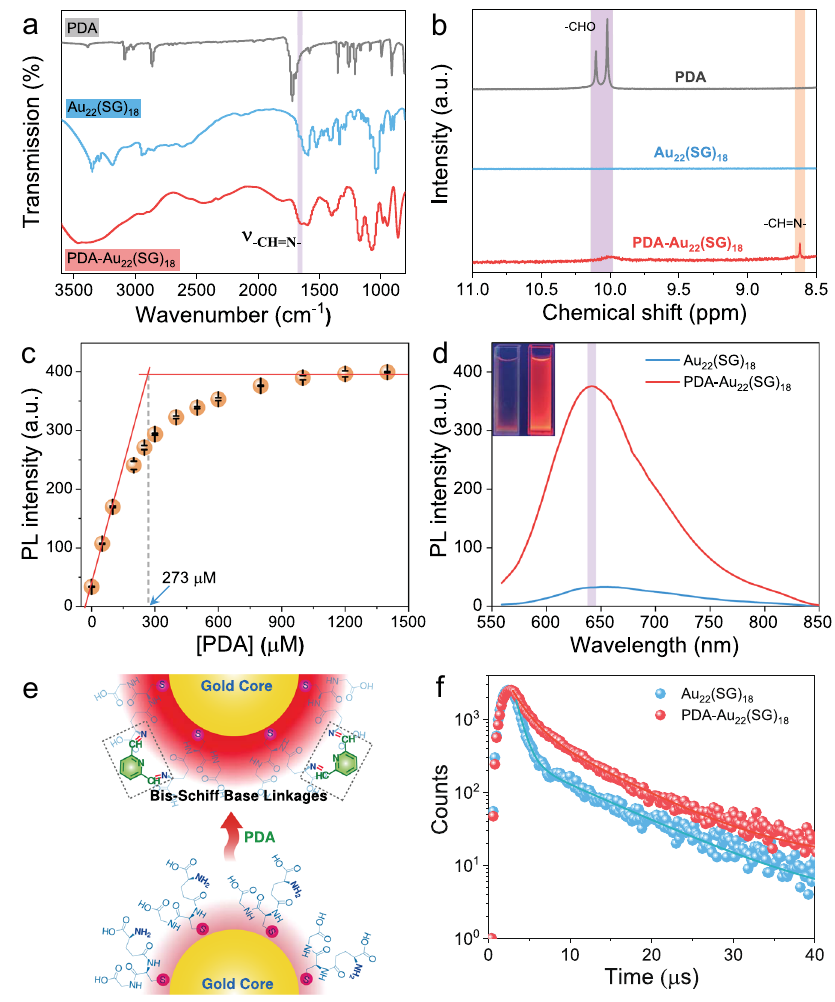
Fig. 3 Interaction between Au 22 (SG) 18 NCs and PDA. a FT-IR spectra of PDA, Au 22 (SG) 18 , and PDA-Au 22 (SG) 18 NCs. The purple area represents an imine stretching vibration region. b 1 H NMR spectra of PDA, Au 22 (SG) 18 NCs, and PDA-Au 22 (SG) 18 NCs. The purple and orange area correspond to the characteristic signals of – CHO and – CH = N – , respectively. a.u. arbitrary units. c PDA concentration-dependent luminescence intensity enhancement for Au 22 (SG) 18 NCs. The solid red lines are tangents of initial and fi nal stages of the titration plots and the dotted line is a guide for intersection point of the tangent lines. The concentration of Au 22 (SG) 18 NCs was 30 μ M. Error bars represent standard deviation over three independent measurements. a.u. arbitrary units. d Photoemission spectra of Au 22 (SG) 18 and PDA-Au 22 (SG) 18 NCs. The purple area shows the maximum emission of PDA-Au 22 (SG) 18 NCs at a shorter-wavelength region. Inset shows the digital photos of Au 22 (SG) 18 (left) and PDA-Au 22 (SG) 18 (right) NCs under UV light. The excitation wavelength was 515 nm. a.u. arbitrary units. e Schematic of the correlation of emission intensity with the binding PDA. The binding of PDA on the Au 22 (SG) 18 surface can induce intramolecular cross-linking of ligands by formation of bis-Schiff linkages, which gives rise to PL enhancement. The red shadings represent PL intensities of Au 22 (SG) 18 NCs before and after the addition of PDA. f Comparison of the luminescence decay of Au 22 (SG) 18 and PDA-Au 22 (SG) 18